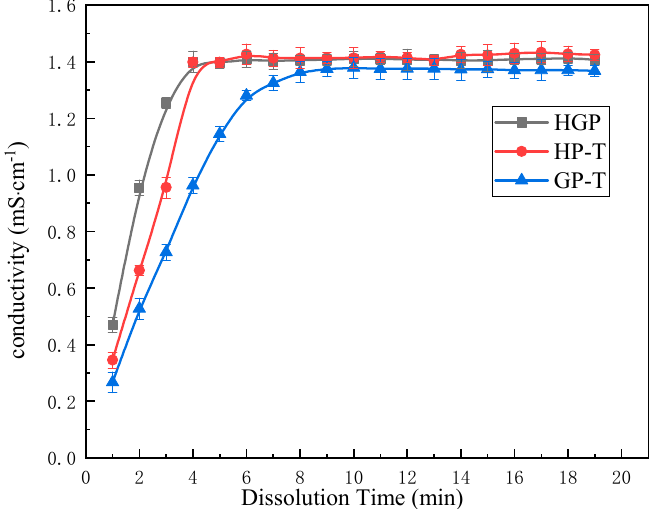
Figure 6. Conductivity changes in the dissolution process of copolymers at 25 °C.